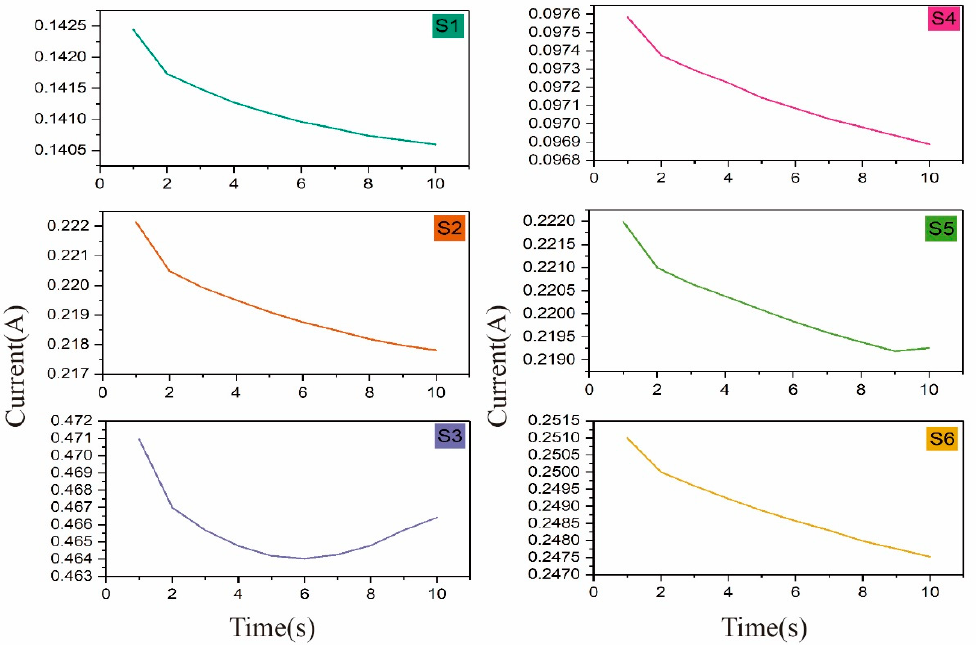
Figure 6. Current values of S1–S6 at 2.4 V in the first 10 s.